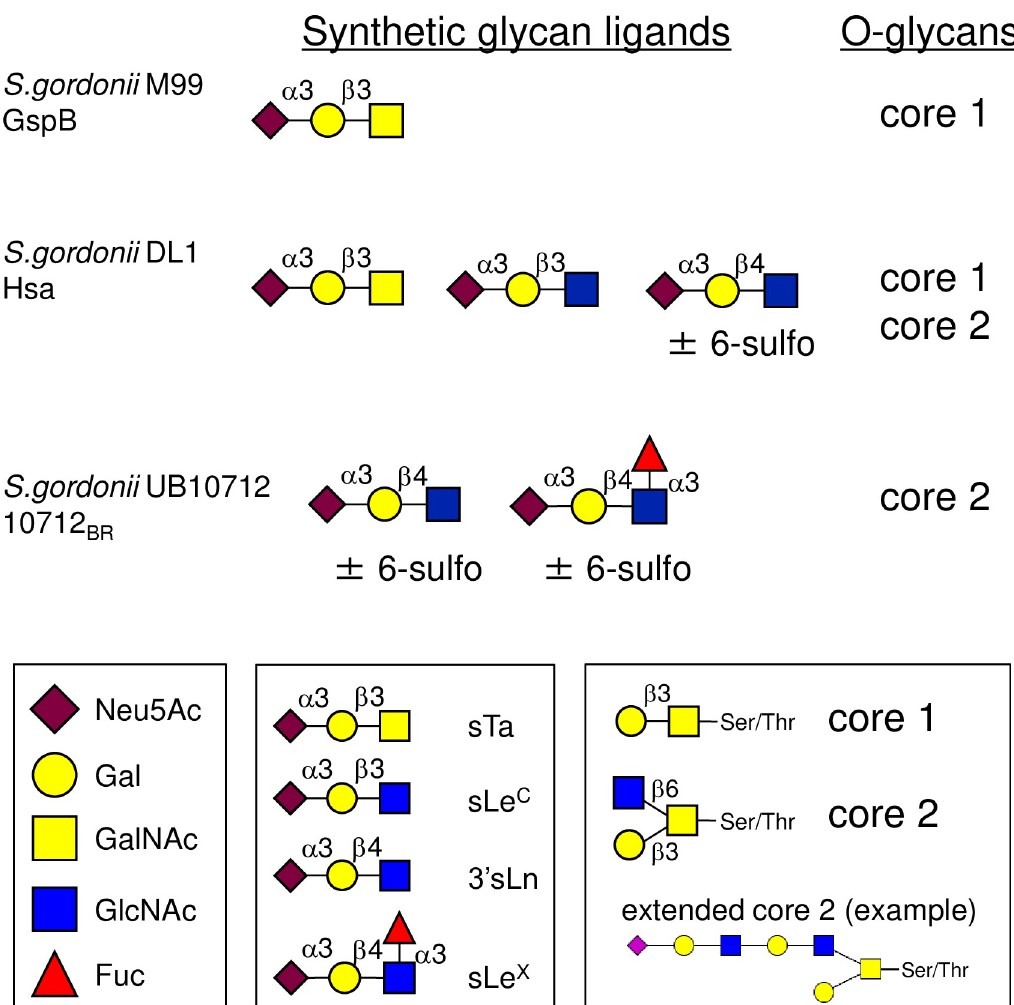
Fig 2. Ligand repertoires determined for three Siglec-like BRs. The high affinity sialoglycan ligands for the recombinant BRs were determined by analysis on a custom sialoglycan array and by enzyme-linked assays [23, 26]. The O-glycan ligand preferences were determined by analyzing glycan profiles of affinity-captured plasma proteins [33]. Note that 10712 BR was previously referred to as NCTC10712 BR . Binding of strains M99 and DL1 to array glycans paralleled binding of the respective recombinant BRs [26]. Monosaccharide symbols follow the Symbol Nomenclature for Glycans system [67]. Neu5Ac, N-acetyl neuraminic acid; Gal, galactose; GalNAc, N-acetyl galactosamine; GlcNAc, N-acetyl glucosamine; Fuc, fucose. sTa, sialyl T- antigen; sLe C , sialyl Lewis C; 3’sLn, 3’sialyllactosamine; sLe X , sialyl Lewis X. Throughout the manuscript, 3’sLn is referred to simply as "sLn". The "core 1" and "core 2" designations refer to the protein-proximal glycan structures.